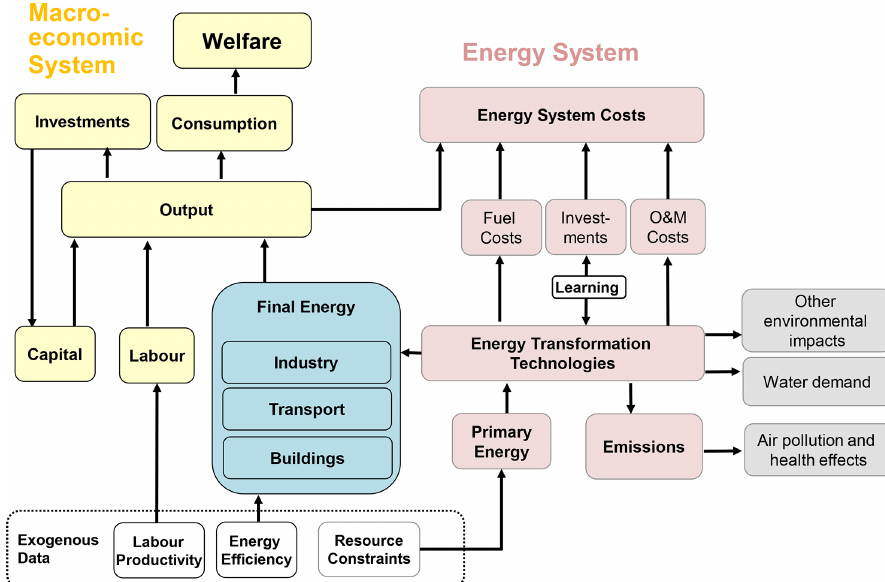
Figure 1. Structure of